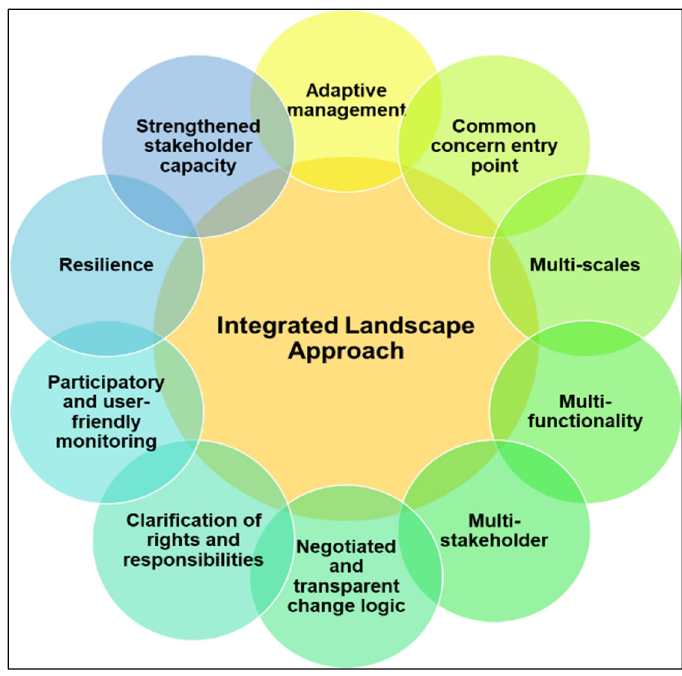
Figure 1. The ten interlinked components of an integrated landscape approach. Adapted from Sayer et al [10].